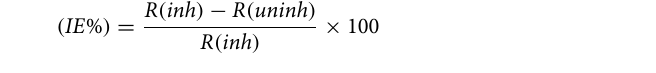
Table 4. CPE data for MS in 1.0 M HCl with nonanedihydrazide (0.5 mM) at various temperatures.